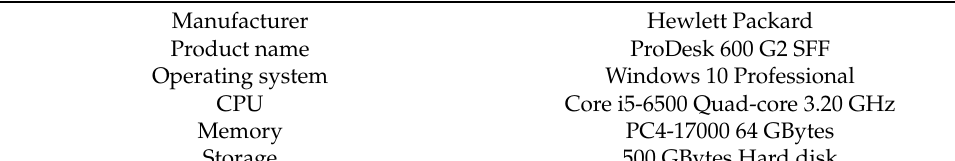
Table 2. Hardware specification used for the finite element analyses.